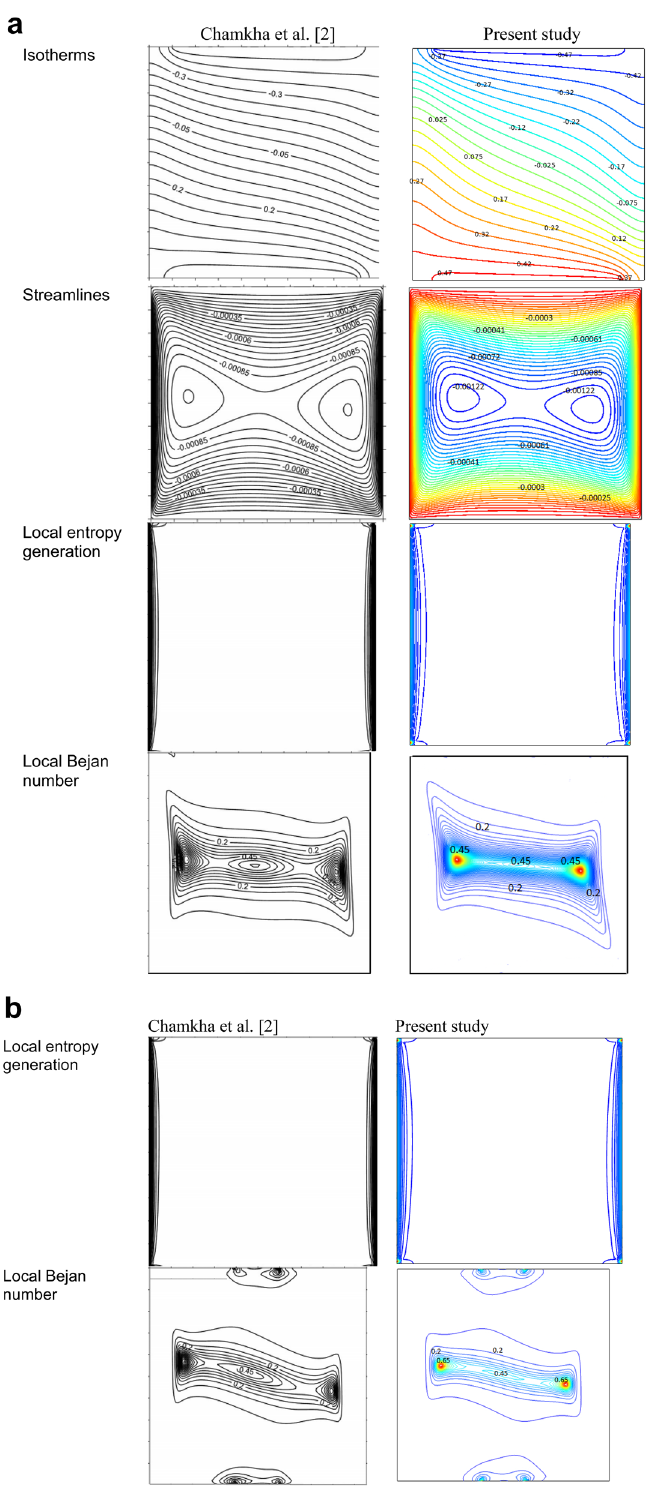
Figure 2. ( a ) Comparison of the present study with Re = 100, Pr = 6.2, Ri = 1, φ = 0.05, Ha = 10, γ = 45, Da = 1e−3, Q = 1.B = 0.8, D = 0.5. ( b ) Comparison of the present study with Re = 100, Pr = 6.2, Ri = 1, φ = 0.05, Ha = 10, γ = 45, Da = 1e−3, Q = 1.B = 0.2, D =